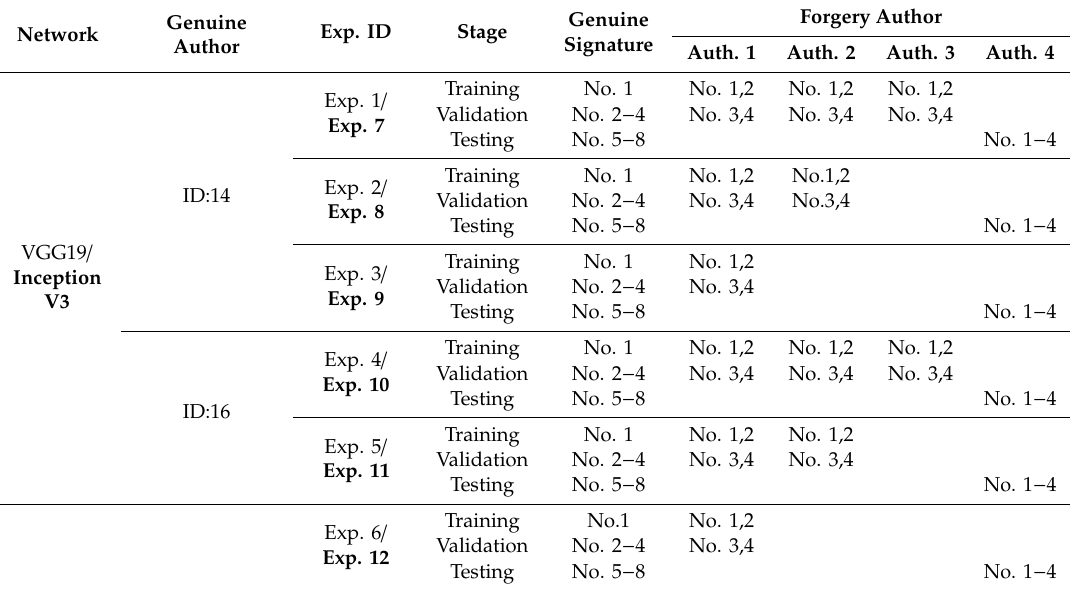
Table 3. The summary of the datasets used in 12